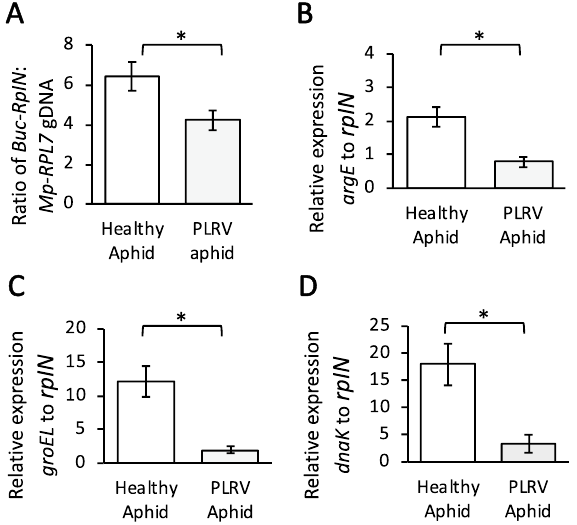
Figure 5. Buchnera aphidicola titer and transcript changes in Myzus persicae with Potato leafroll virus (PLRV). (A) Ratio of a single copy Buchnera gene rpIN relative to a single copy aphid gene RPL7, demonstrates M. persicae with PLRV have a decreased Buchnera aphidicola titer relative to control aphids. (B–D) Buchnera transcripts groEL , dnaK , and argE relative to the Buchnera gene rpIN housekeeping gene. All three transcripts were down-regulated in viruliferous M. persicae compared to virus free controls. Significant differences were calculated using an ANOVA (* P < 0.05; Error bars represent ±